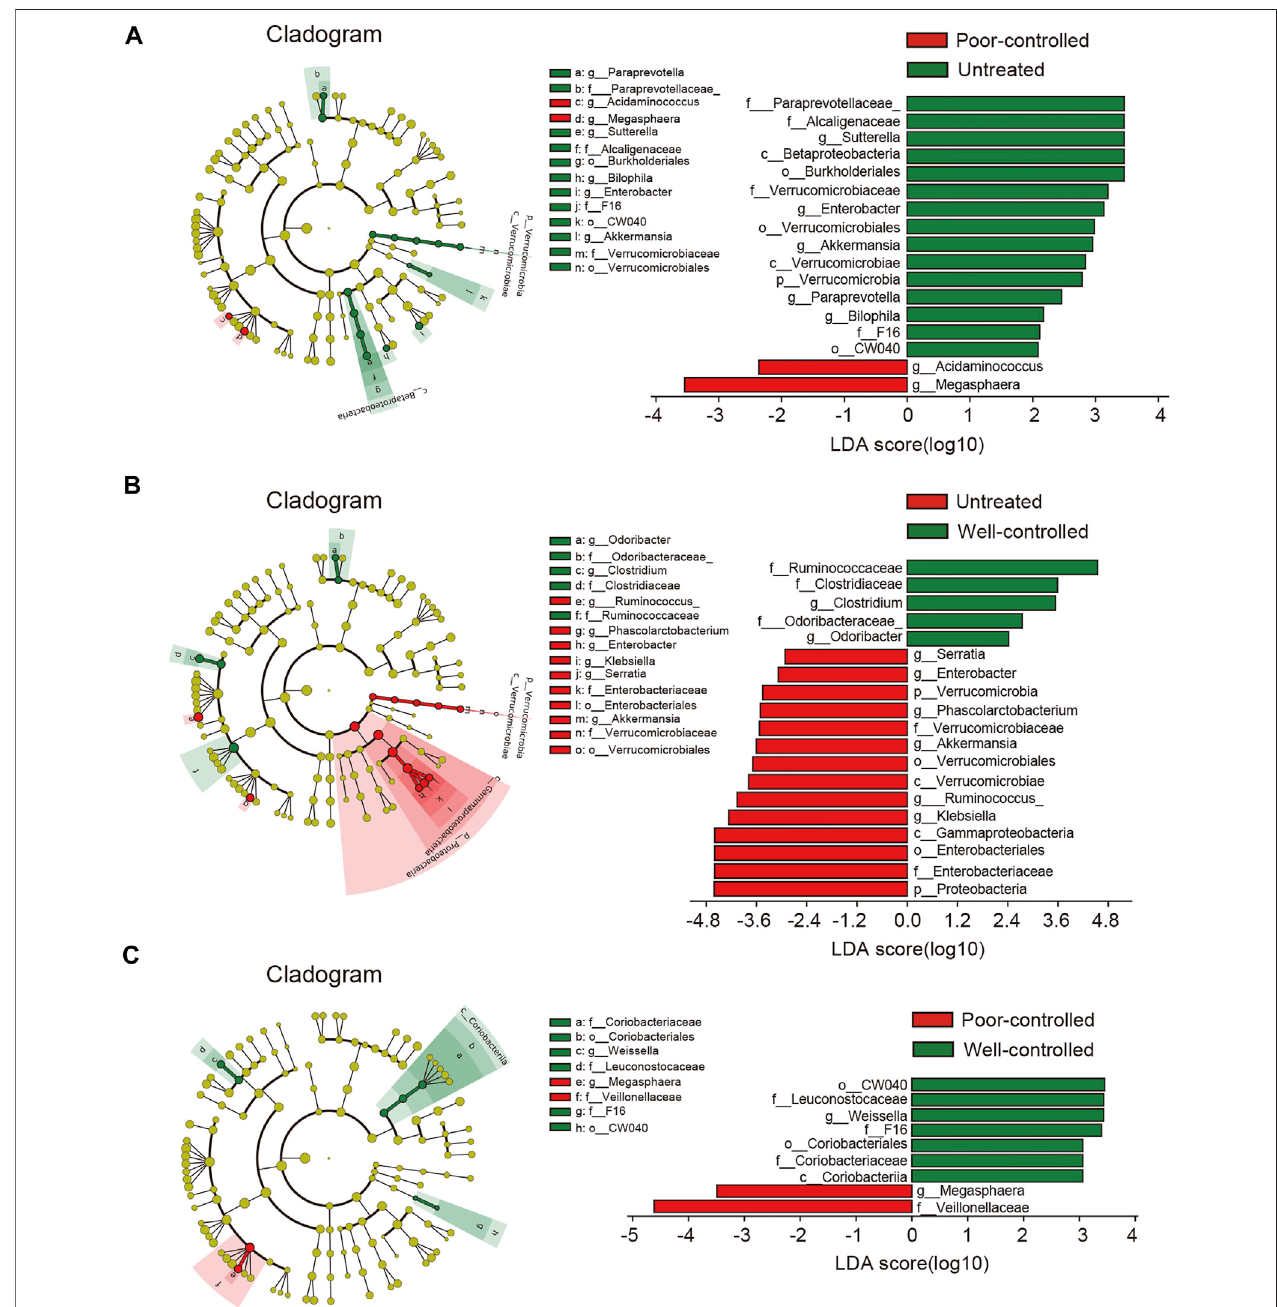
FIGURE 3 | LEfSe analysis revealed differences in the fecal taxonomic composition between the poor-controlled or well-controlled hypertensive patients under ACEI/ARB therapy compared with untreated subjects. (A) Cladogram and LDA score of signi fi cantly different taxonomic compositions in poor-controlled (red) HTN patients relative to untreated (green) ones. (B) Signi fi cantly altered gut microbiota by ACEI/ARB in BP well-controlled individuals as compared with an untreated group are shown in LEfSe cladogram. Taxon abundant in untreated (red) and well-controlled (green) HTN patients are further presented with LDA scores. (C) Cladogram describing the microbial shifts in taxonomic composition between poor-controlled (red) and well-controlled (green) groups. The signi fi cance of different variables is de fi ned by LDA scores (log10) > 2. Variants with p values < 0.1 are shown.